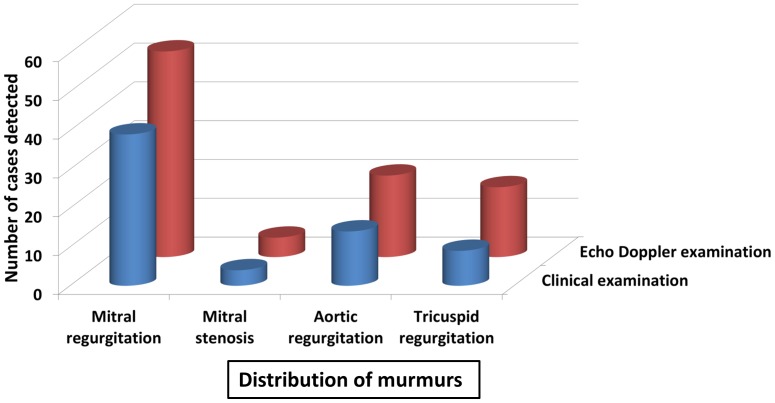
Clinical and echocardiographic examination of ARF patients.